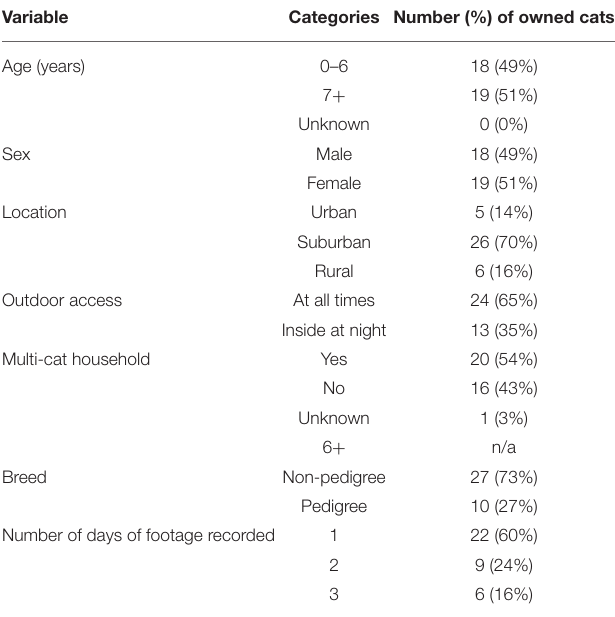
TABLE 1 | Summary of cat